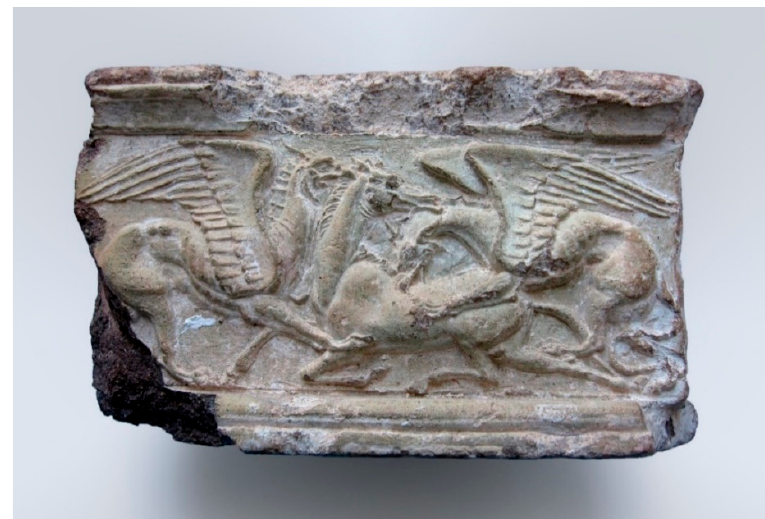
Figure 5. Two winged griffins attack a horse (MGW inv. no. 513); terracotta altar ( arula ); ca. 5th–4th century BCE .